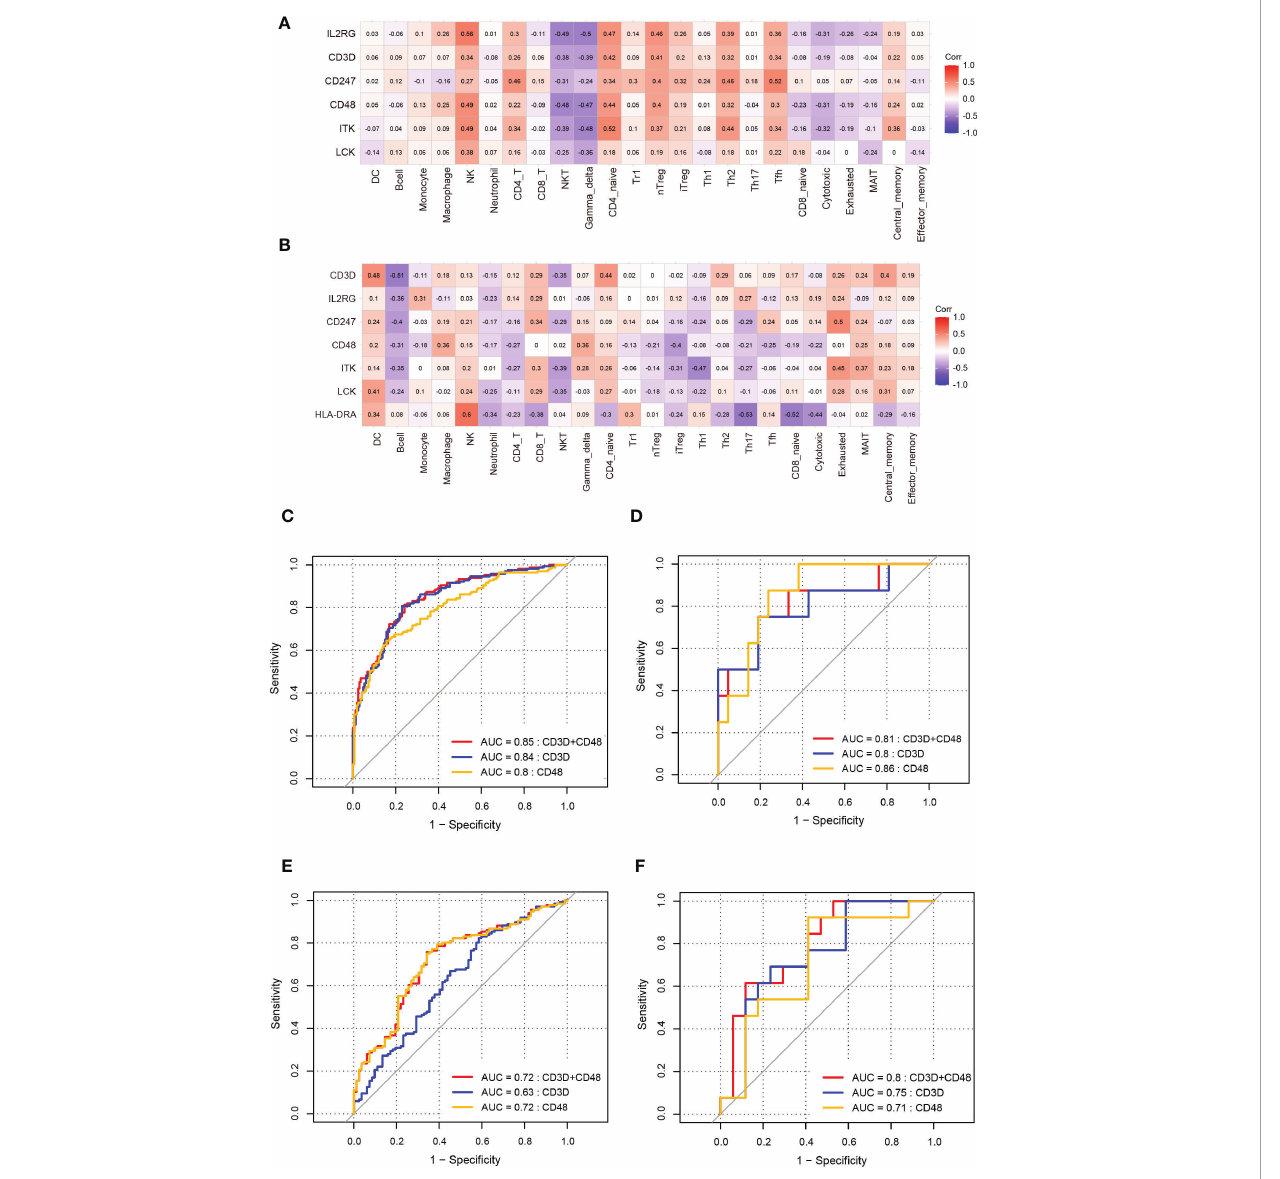
FIGURE 10 Validation of correlation between hub immune-related genes and 24 immune cells and ROC analysis of biomarkers in DCM and AF. (A, B) The correlation between hub immune-related genes and 24 immune cells in datasets GSE57338 (DCM), GSE115574, and GSE31821(AF). (C) ROC analysis of each hub immune-related genes in the training dataset (DCM). (D) ROC analysis of each hub immune-related genes in the training dataset (AF). (E) The GSE57338 dataset was used to validate the diagnostic effectiveness of the biomarkers for DCM by ROC analysis. (F) The GSE115574 and GSE31821datasets were used to validate the diagnostic effectiveness of the biomarkers for AF by ROC